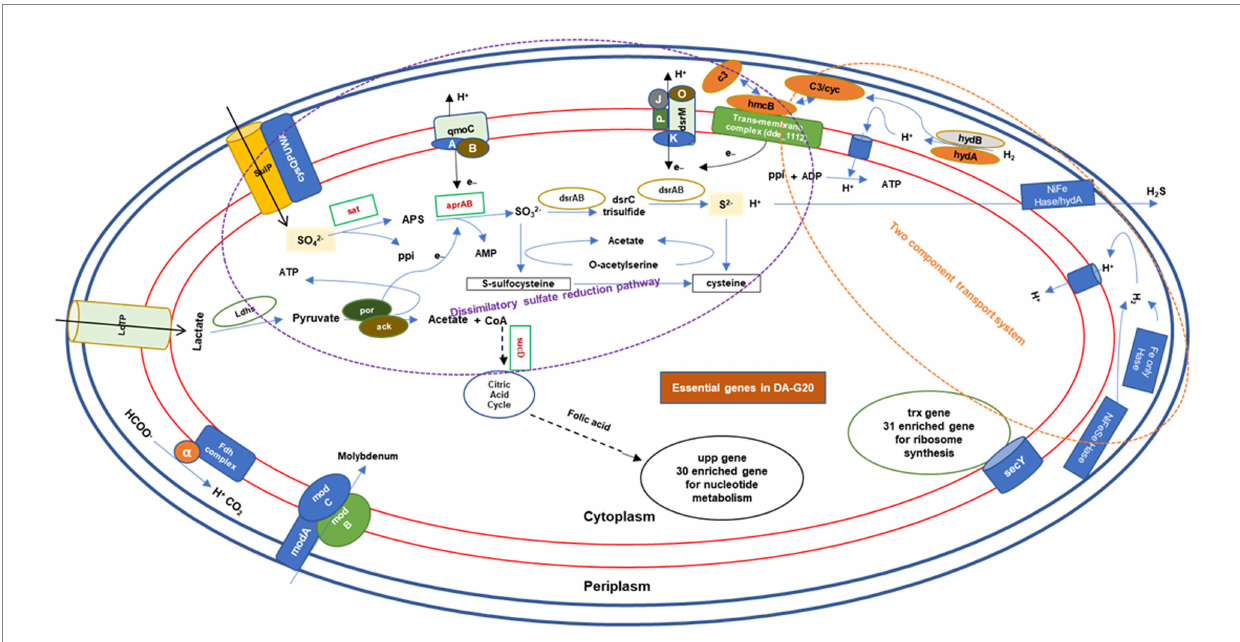
FIGURE 8 The mechanism of essential genes towards OA G20 survival. AMP, adenosine monophosphate; ATP, adenosine triphosphate; ADP, adenosine diphosphate; LDH, lactate dehydrogenase; LdtP, L,D-transpeptidase; SulP, sulfate permease; por, pyruvate:ferredoxin oxidoreductase; ack, acetate kinase; CoA, CoenzymeA; and ppi, inorganic